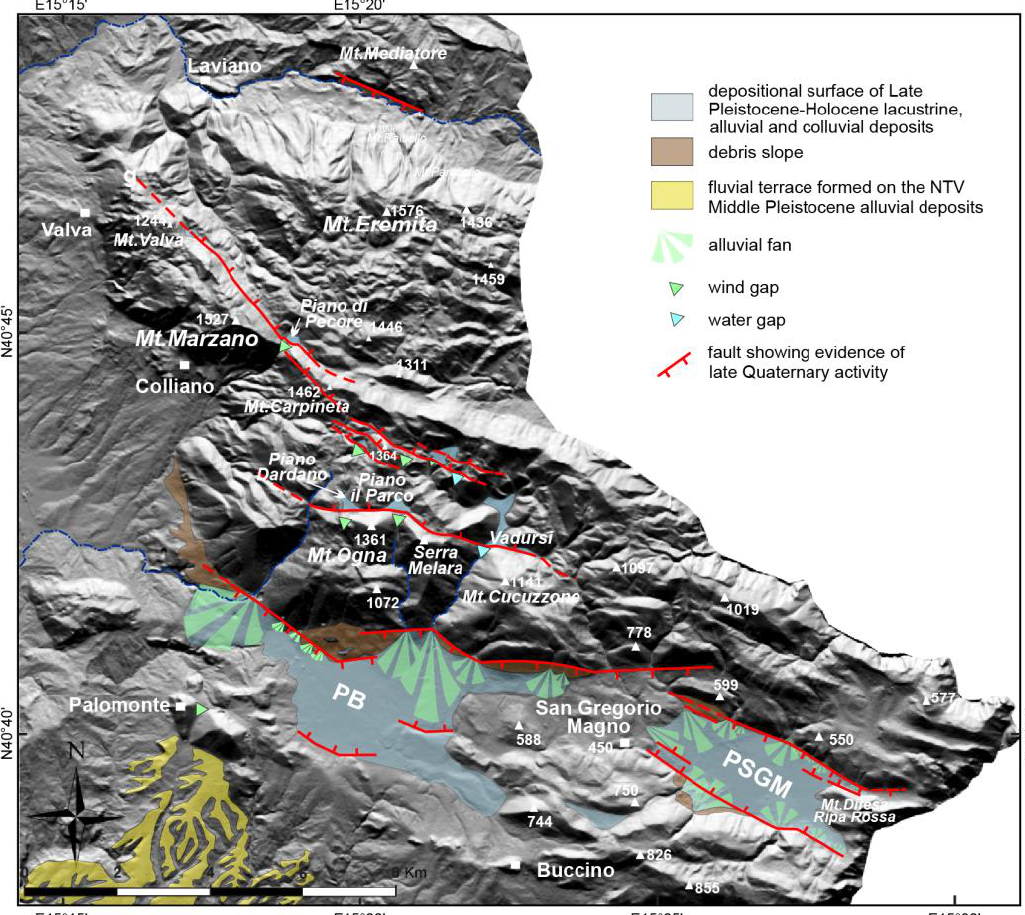
Figure 3. Faults showing evidence of late Quaternary activity in the Mt. Marzano ridge area (redrawn after Ascione et al. [7]).